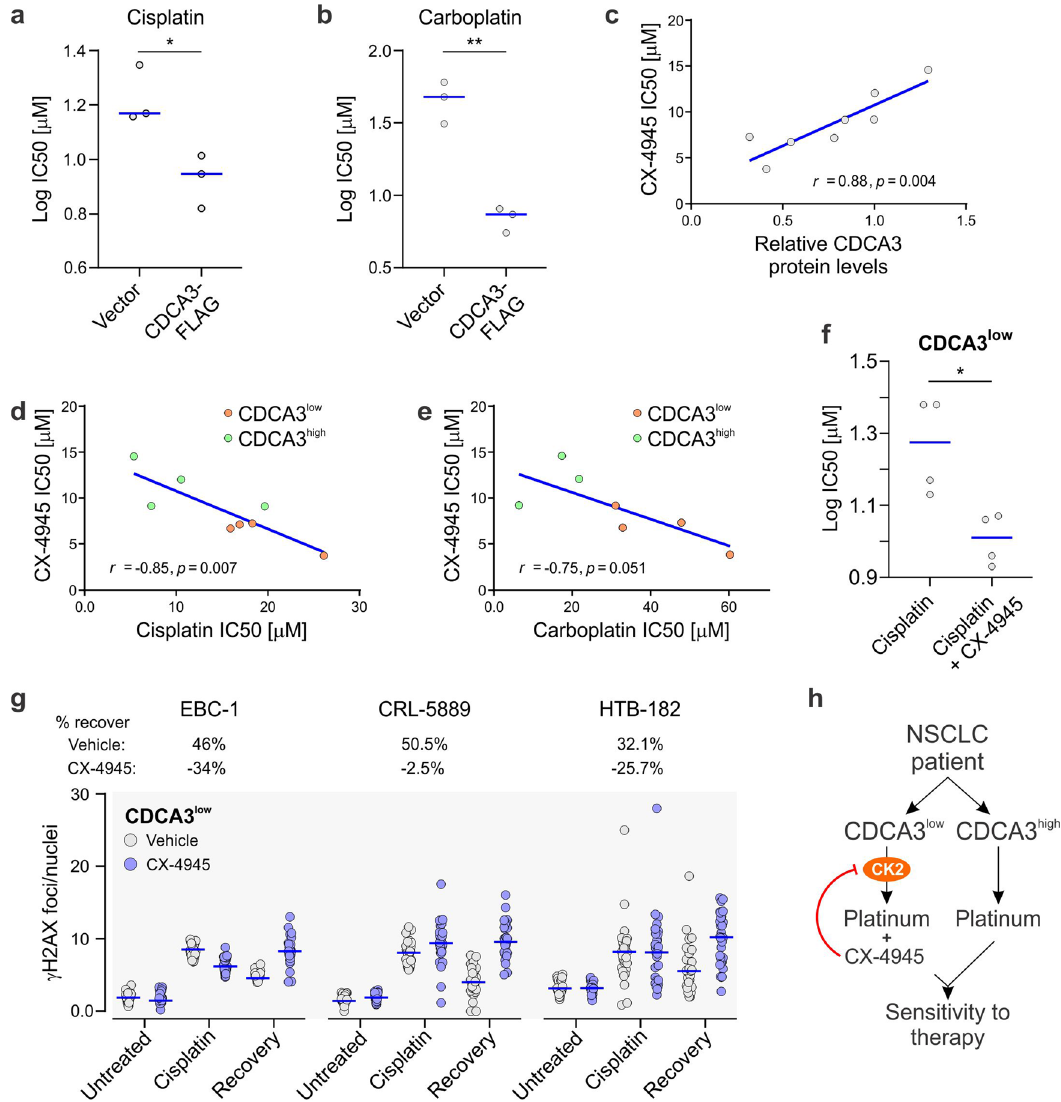
Fig. 6 Combining CK2 inhibitors with cisplatin in CDCA3 low NSCLC. a Beeswarm plots showing the impact of ectopic CDCA3 overexpression in CDCA3 low NSCLC cell lines upon cisplatin dose responses. Blue line indicates median cisplatin IC 50 value. (unpaired Student ’ s t test, * P = 0.0234). b Beeswarm plots showing the impact of ectopic CDCA3 overexpression in CDCA3 low NSCLC cell lines upon carboplatin dose responses. Blue line indicates median cisplatin IC 50 value. (unpaired Student ’ s t test, ** P = 0.0012). a , b The CDCA3 low cell lines used include EBC-1, CRL-5889 and HTB-182 cells. c Scatter plot showing linear regression analysis assessing correlation between CDCA3 protein levels, and in vitro CX-4945 sensitivity which is represented by IC 50 values, as per Fig. 1g. CX-4945 IC 50 values calculated dose responses indicated in Supplementary Fig. 4. Data points represent NSCLC cell lines. R and P values determined according to Pearson correlation. d Scatter plot assessing correlation between cisplatin and CX-4945 IC 50 sensitivities with NSCLC cell lines with high (green) and low (orange) CDCA3 indicated. e Scatter plot assessing correlation between carboplatin and CX-4945 IC 50 sensitivities with NSCLC cell lines with high (green) and low (orange) CDCA3 indicated. d , e Linear regression determined according to Pearson correlation with R and P values displayed. f Beeswarm plots showing the impact of CX-4945 IC 25 concentrations upon cisplatin dose responses in NSCLC cell lines with low CDCA3 levels. Blue line indicates median cisplatin IC 50 value. (unpaired Student ’ s t test, * P = 0.0138). g Beeswarm plots showing γ H2AX foci count per nucleus determined from high throughput immuno fl uorescence microscopy of EBC-1, CRL-5889 and HTB-182 NSCLC cell lines with low CDCA3 protein levels (determined in Fig. 1g). γ H2AX foci counts were determined in cell lines exposed to the presence (blue data points) or absence (grey data points) of CX-4945 and either cisplatin treated for 12 h (cisplatin) or untreated. Foci counts were also determined in recovering cells following treatment with cisplatin alone or in combination with CX-4945 following cisplatin treatment (recovery). Data points calculated as per Fig. 1h from n = 13 – 16 fi elds of view. Blue lines indicate median values. Percent recovery calculated by difference between 100% and ratio of recovery/cisplatin expressed as a percentage. h Schematic representing proposed strategy to use CDCA3 as a potential companion diagnostic for CX-4945 to improve the sensitivity of NSCLC tumours to platinum-based